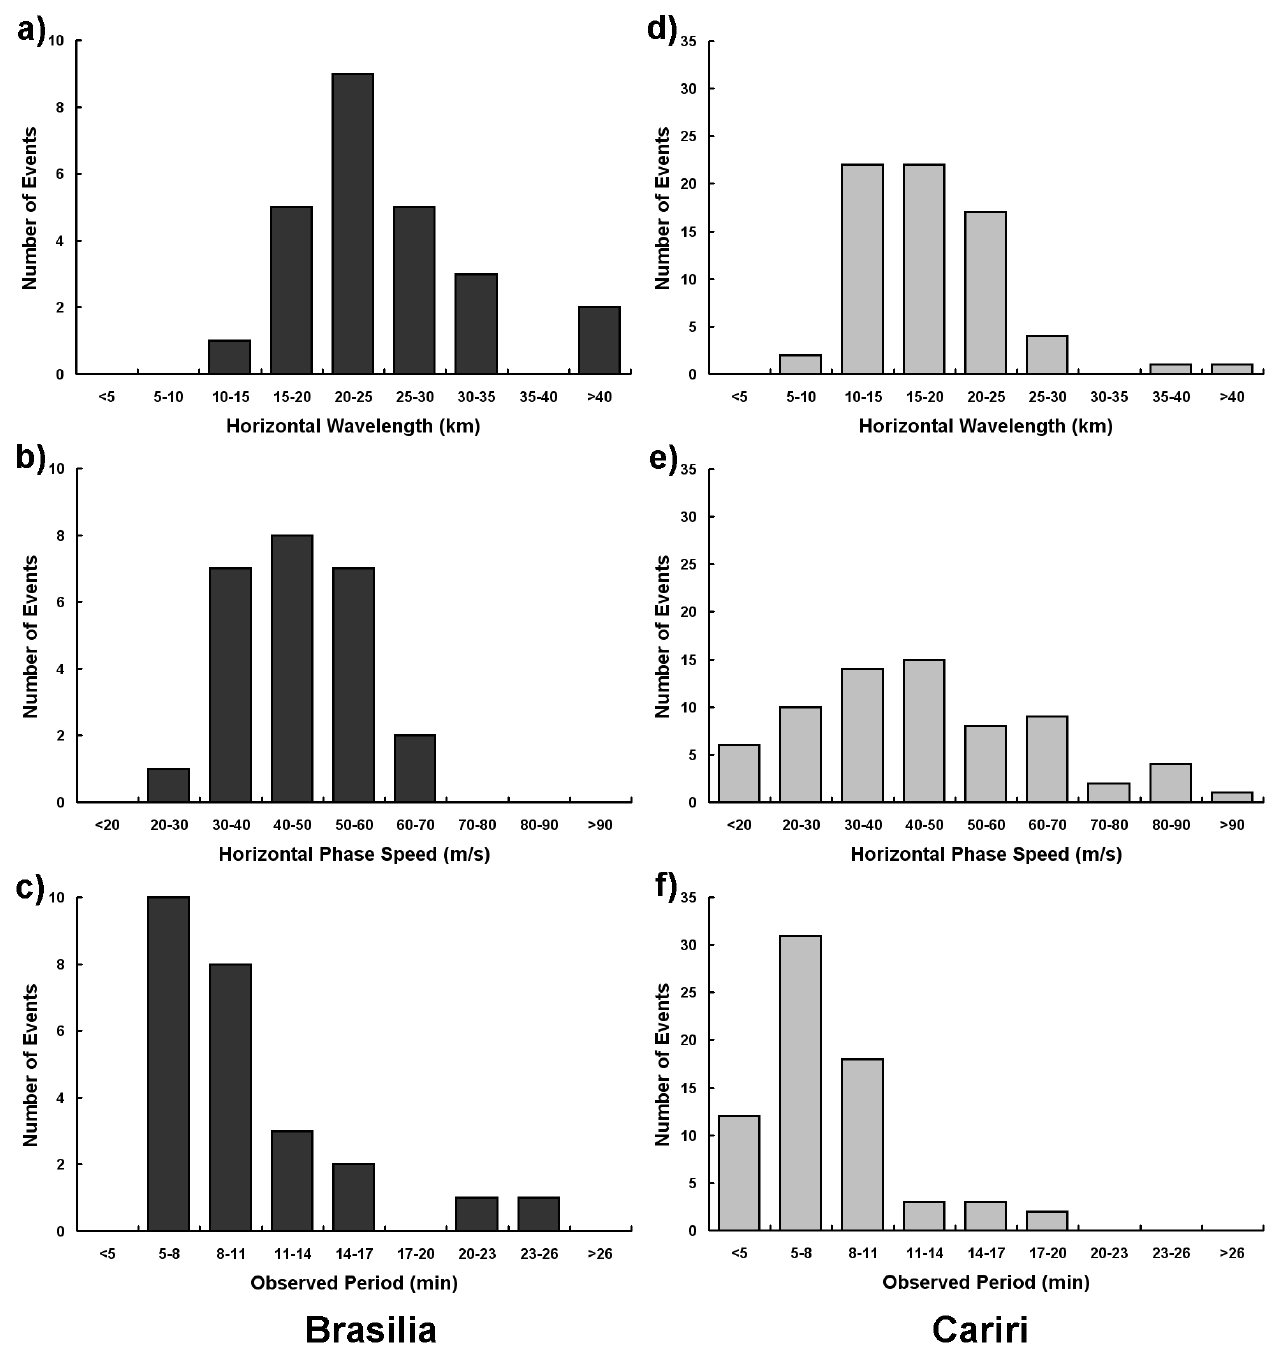
Fig. 3. Histogram plots summarizing the characteristics of the short-period wave events observed from Brasilia (left) and Cariri (right). The uncertainties in the small-scale wave measurements are λ x ± 3km, v x ± 5m/s, θ ± 5 ◦ and τ ± 2min. Note the different